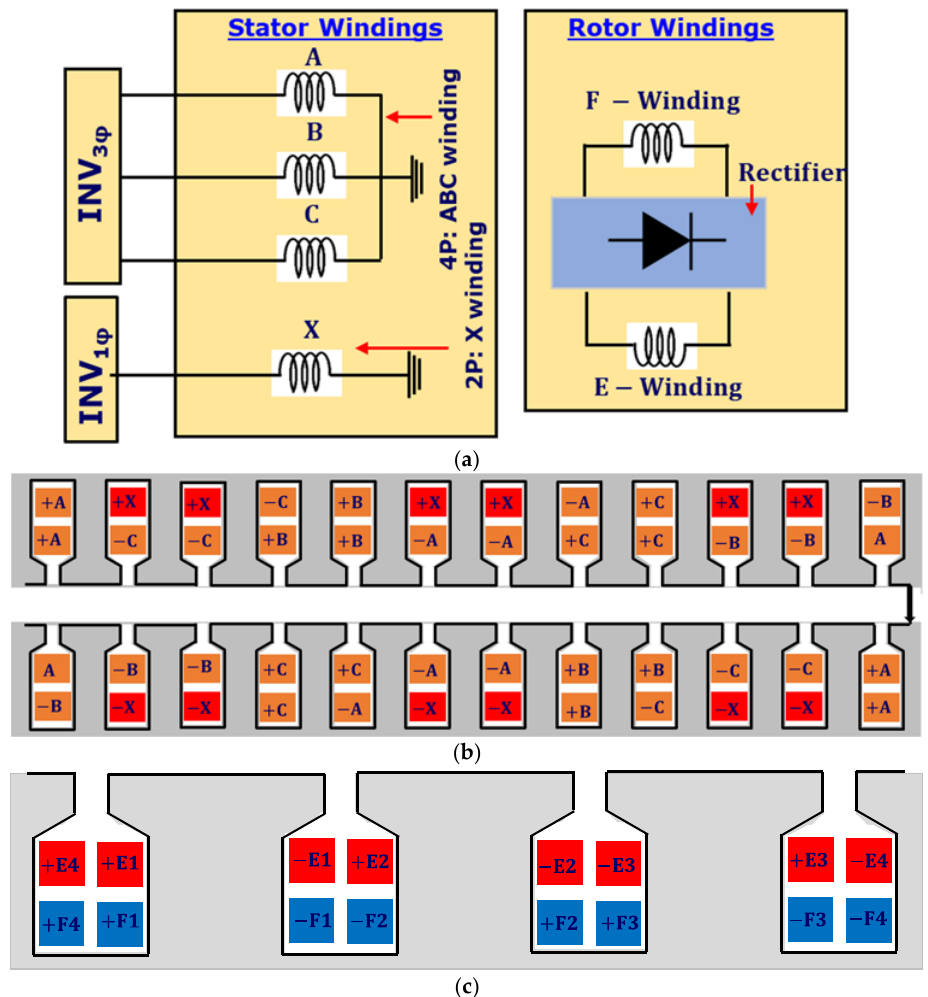
Figure 5. ( a ) Topology of proposed machine, ( b ) stator winding, ( c ) rotor winding.